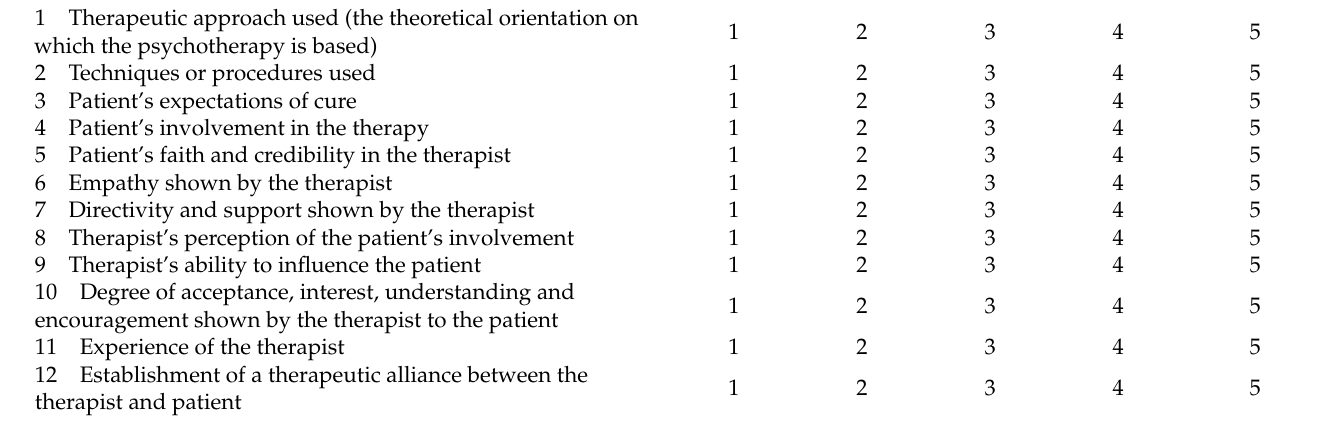
Table A1. Psychotherapeutic Effectiveness Attribution Questionnaire